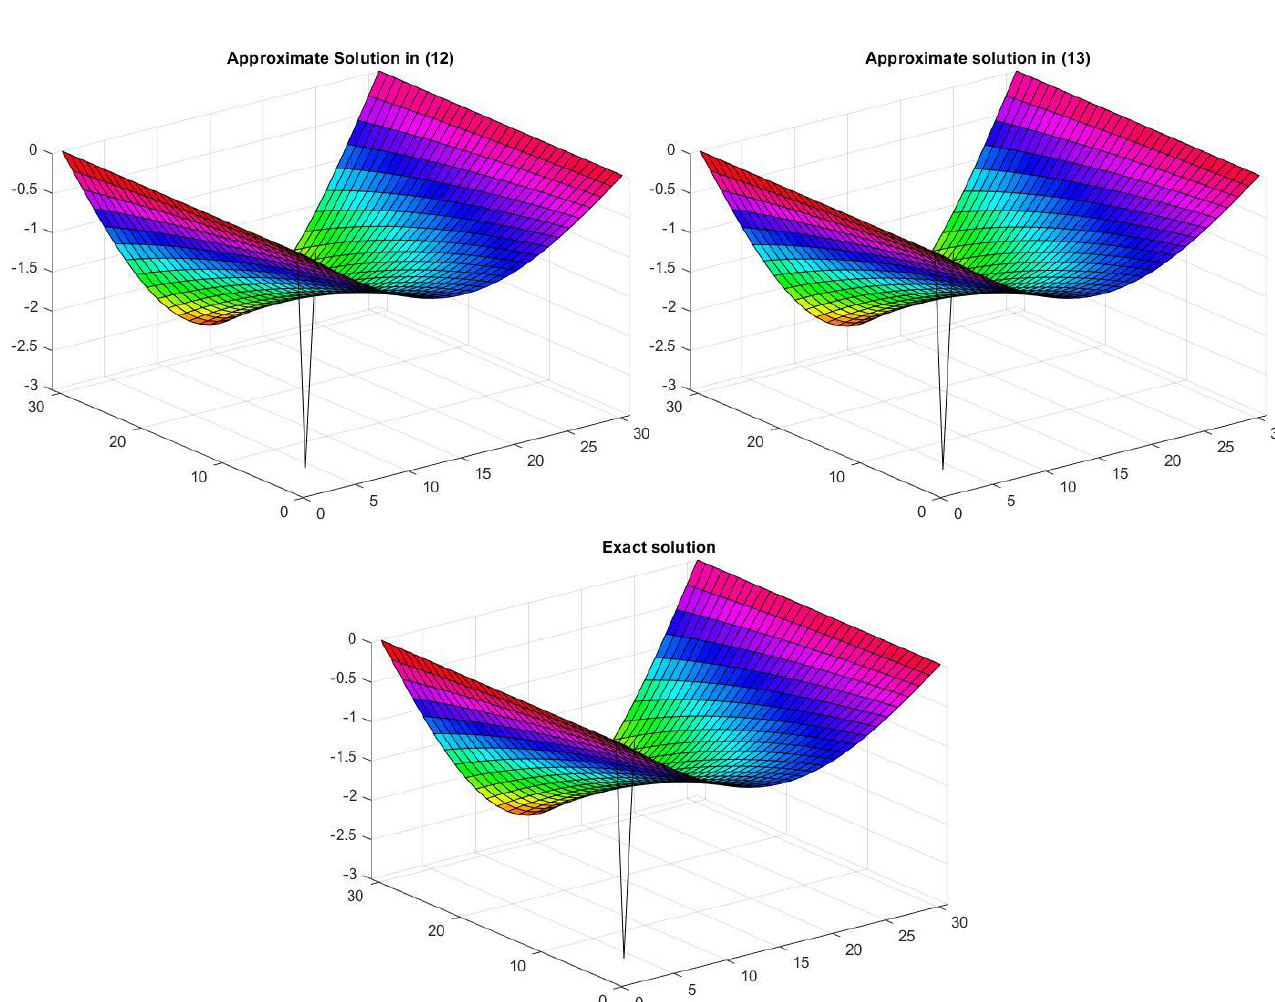
Figure 3. Exact solution and numerical solution for the problem (11) where